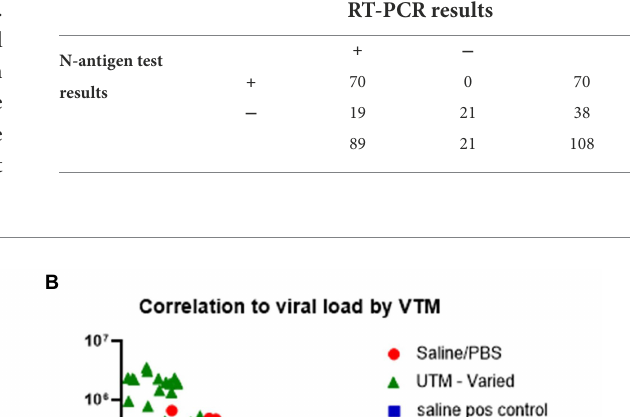
TABLE 1 Overall assay